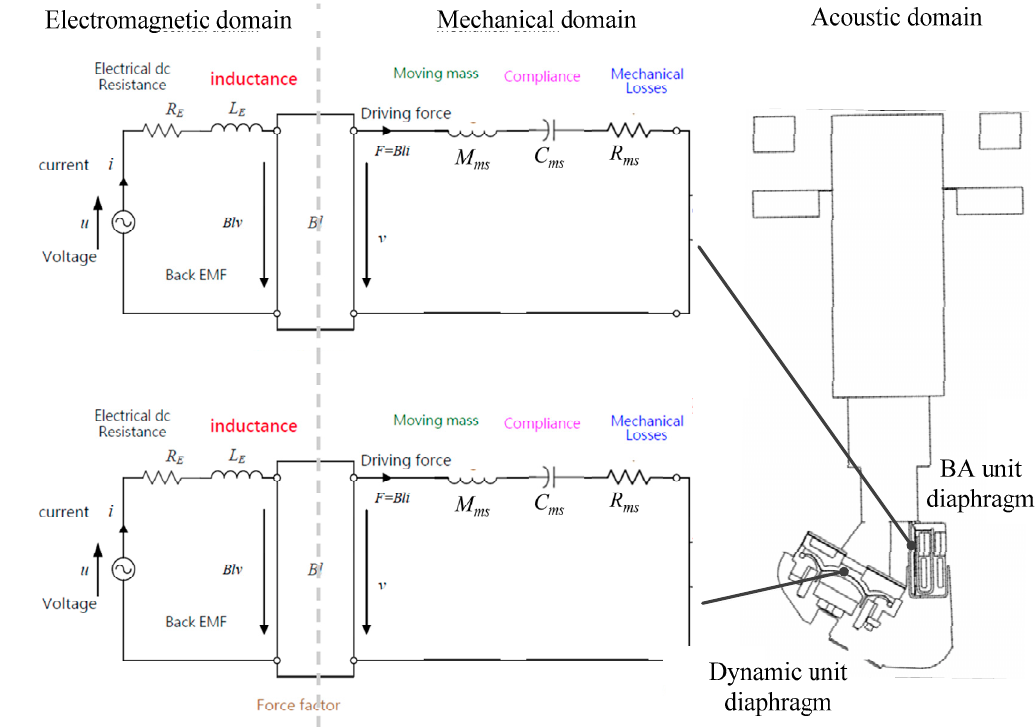
Figure 9. Analysis tool for hybrid earphone.